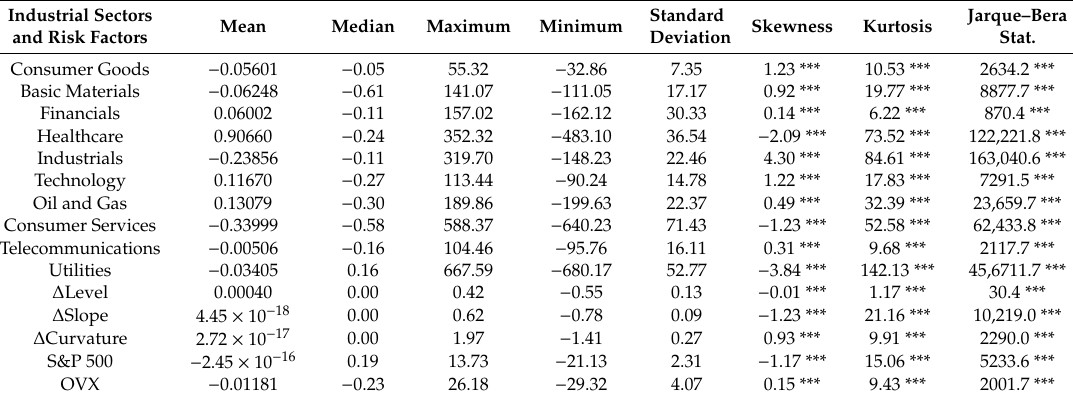
Table 2. Descriptive statistics of returns for the U.S. industrial sectors and risk variables.